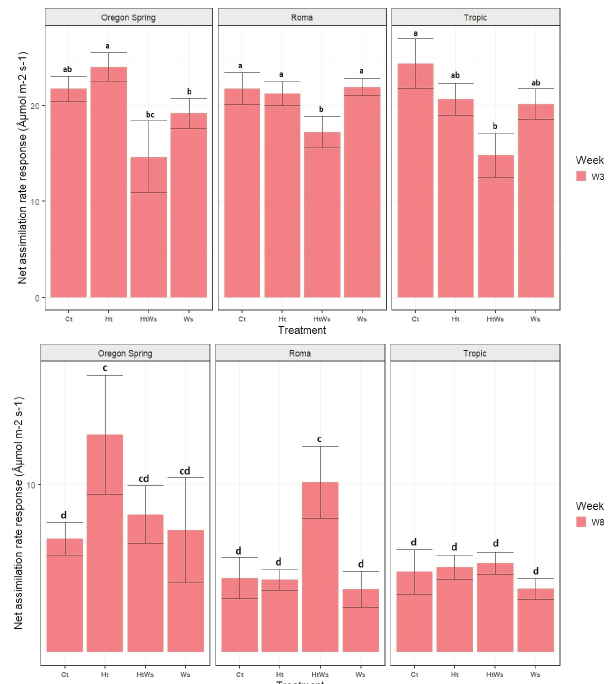
Fig. 4 ­ Net assimilation rate response (µmol m ­2 s ­1 ) of the three tomato varieties (Oregon Spring, Roma and Tropic). The treatments consist of Control (Ct), Water stress (Ws), Heat + Water stress (HtWs) and Heat (Ht). W3 and W8 = weeks of treatments imposition with measurements. Bars with the same letter are not significantly different at P<0.05 according to Turkey's